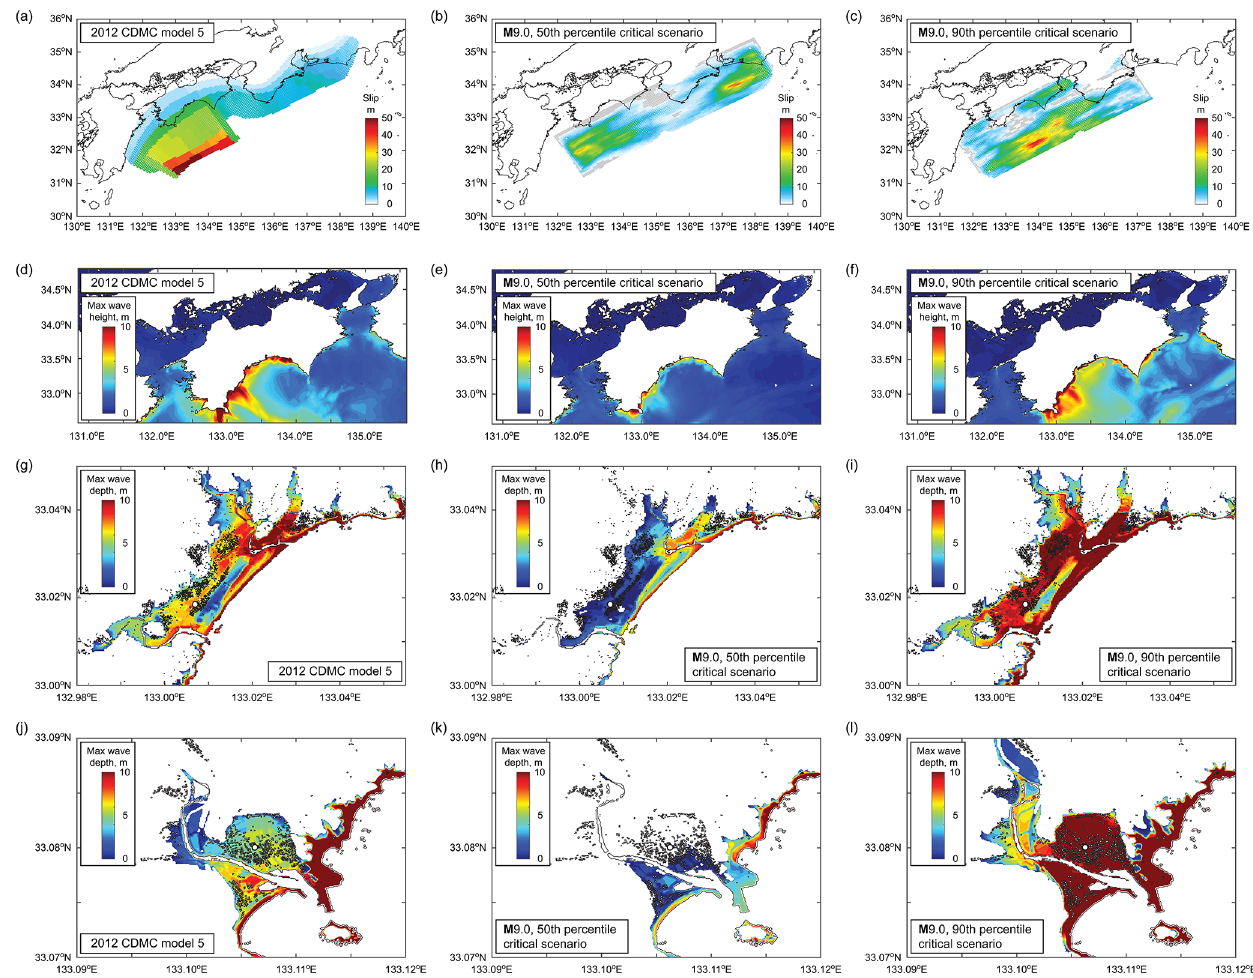
Figure 13. Critical tsunami hazard scenarios for the Ogata and Saga districts for the M 8.9–9.1 magnitude range. Panels (a, d, g, j) correspond to the most critical scenario based on the 2012 CDMC models (i.e., model 5). Panels (b, e, h, k) and (c, f, i, l) correspond to the 50th and 90th percentiles of inundation areas in the Ogata and Saga districts (Fig.